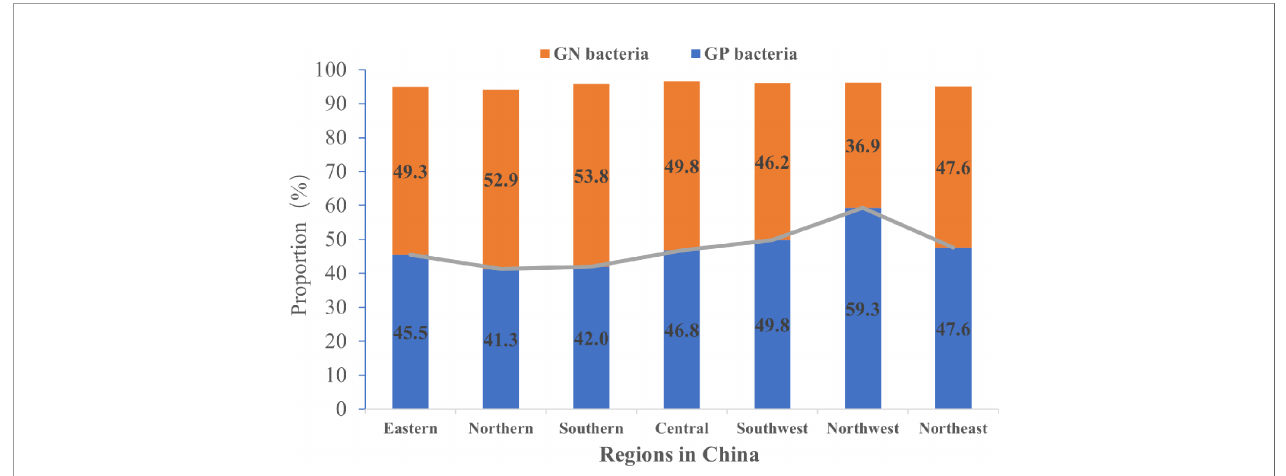
FIGURE 3 | The proportions of GN and GP bacteria in different regions of China.